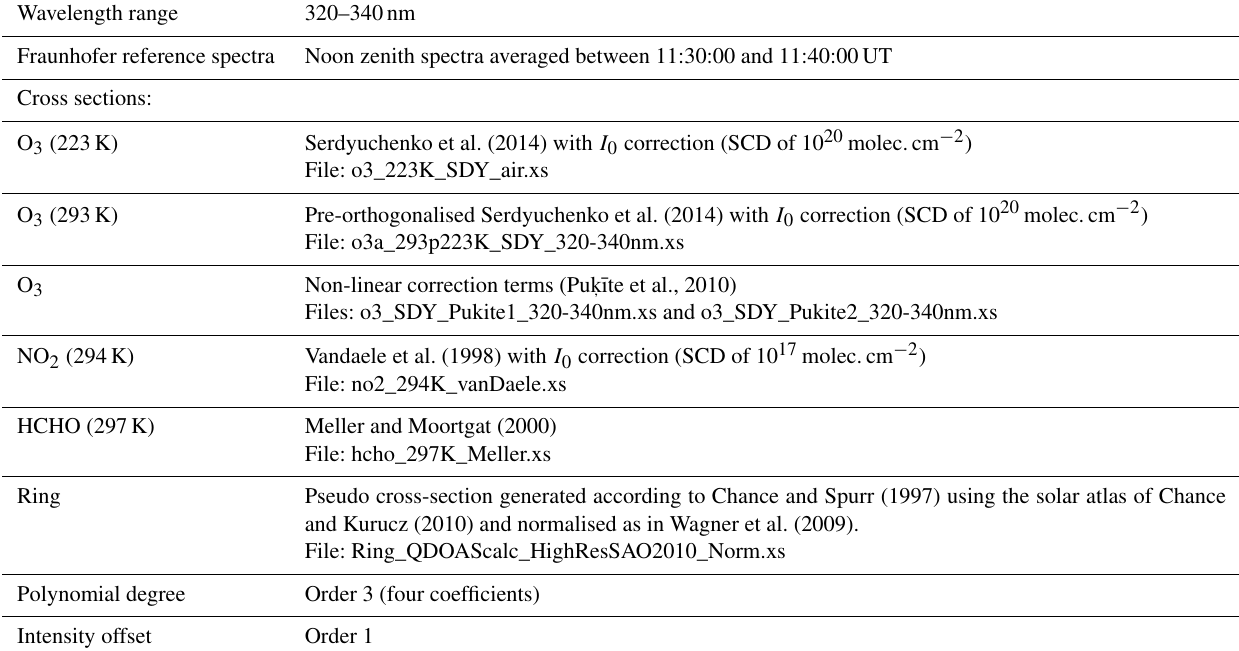
Table A6. DOAS settings ozone in the Huggins band. Wavelength